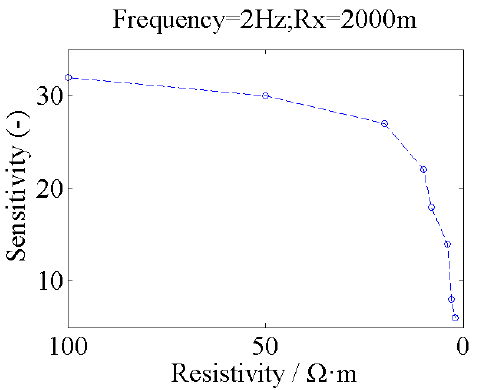
Figure 5. CSEM sensitivity varies with targets resistivity.